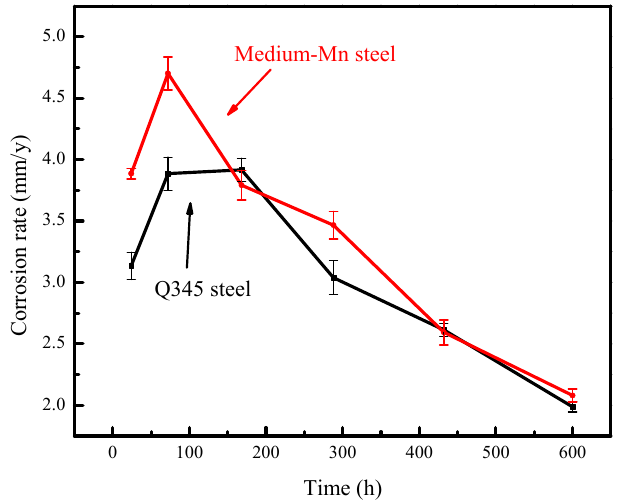
Figure 1. Corrosion rates of the tested medium-Mn steel and Q345 steel exposed to a 3.5 wt % NaCl solution for different lengths of time at 25 °C.